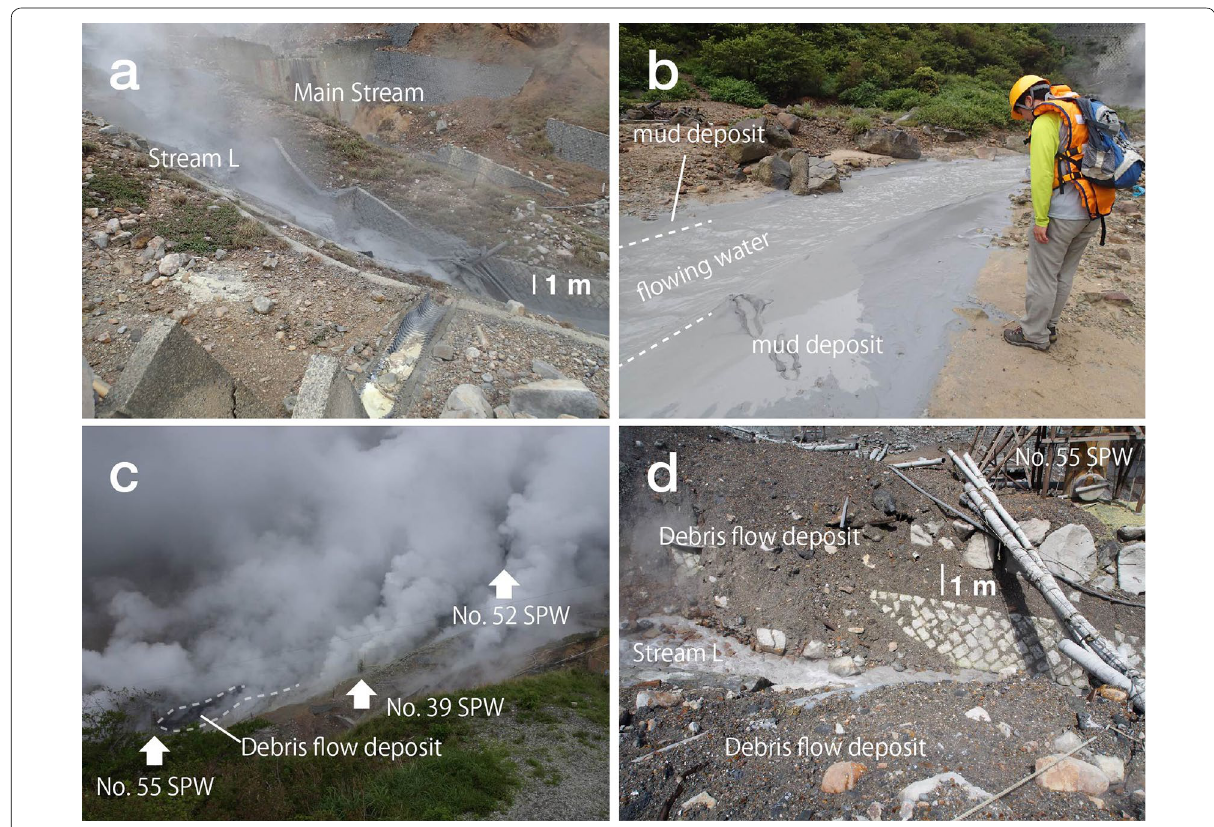
Fig. 12 Photographs of mud and debris flows. See Fig. 2 for shooting locations. a Lahar flowing down Stream L in Owakudani (15:56 of June 29). b A flow channel downstream of a . Note that mud deposits are wider than that of the stream width at that time, which implies a higher flux of mud flow in the early phase of the eruption (15:09 of June 29). c Eruption center during the eruption (17:29 of June 29). Debris flow deposit had been emplaced. d Debris flow deposits near no. 55 SPW (9:10 of July 10). Note that the stream across the debris flow deposit (Stream L) is colored gray, even 9 days after the eruption. Large rocks on the left bank and right of the scale were set before eruption by the company to protect no. 55 SPW. All photographs were taken by